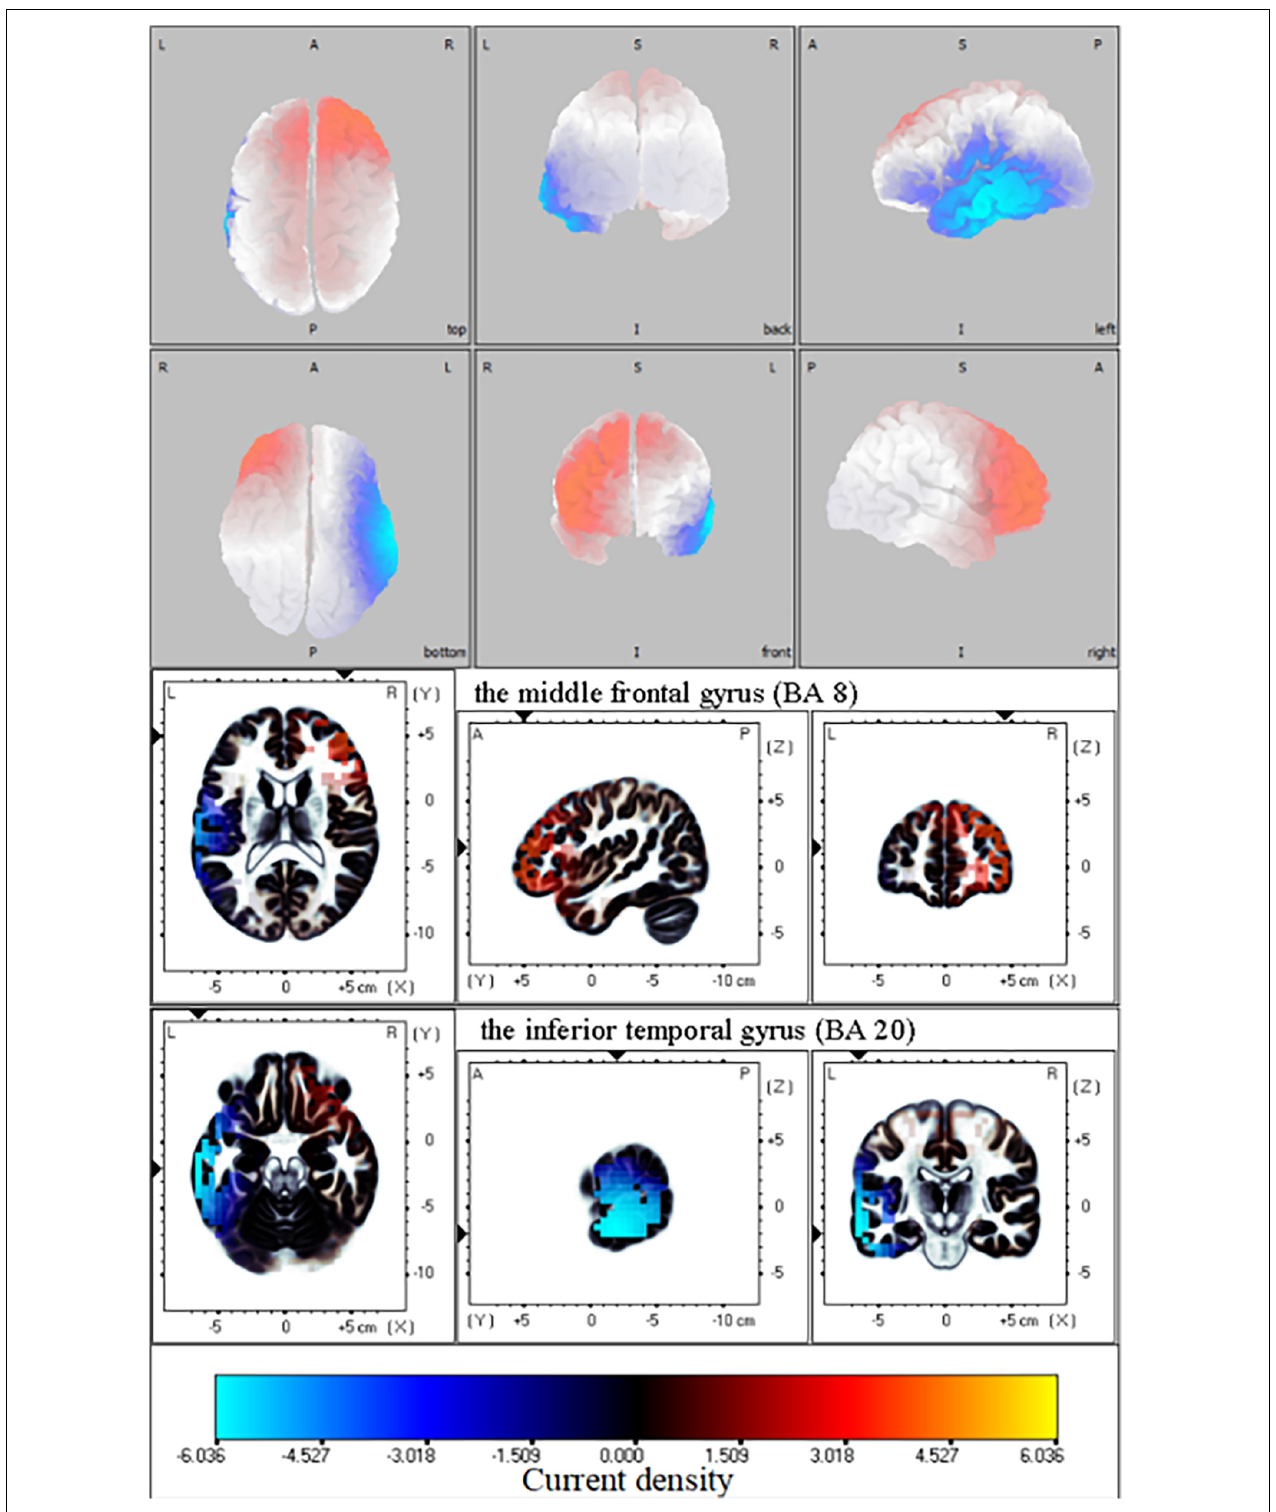
FIGURE 3 | Functional independent component analysis (fICA): Neural oscillation changes in resting state. Changes in right frontal lobe and left temporal lobe information transmission between amputation group and healthy group in beta-3 band (21.5—30 Hz); The bright yellow indicates increased beta oscillation in amputee group, while blue color denotes the beta oscillation was weakened in amputee group relative with healthy group. L, left; A, anterior; R, right; P, posterior; S, superior; I, inferior.